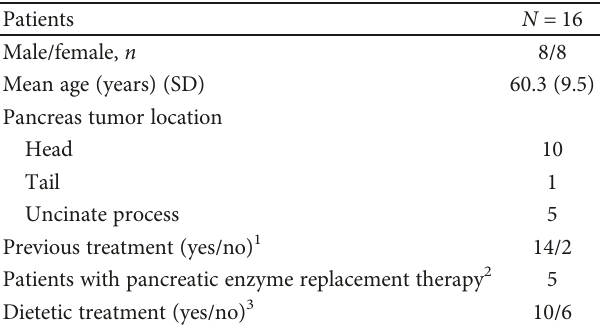
Table 1: Characteristics of the group of patients with LAPC at